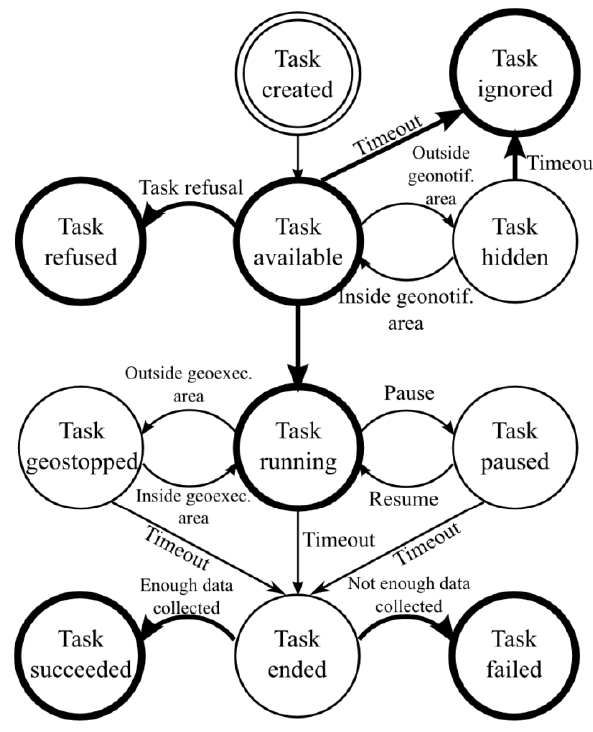
Figure 1. Task state lifecycle. Data collection is enabled only in the running state. States with a bold stroke reached through transitions represented with a bold arrow are kept in sync between clients and the